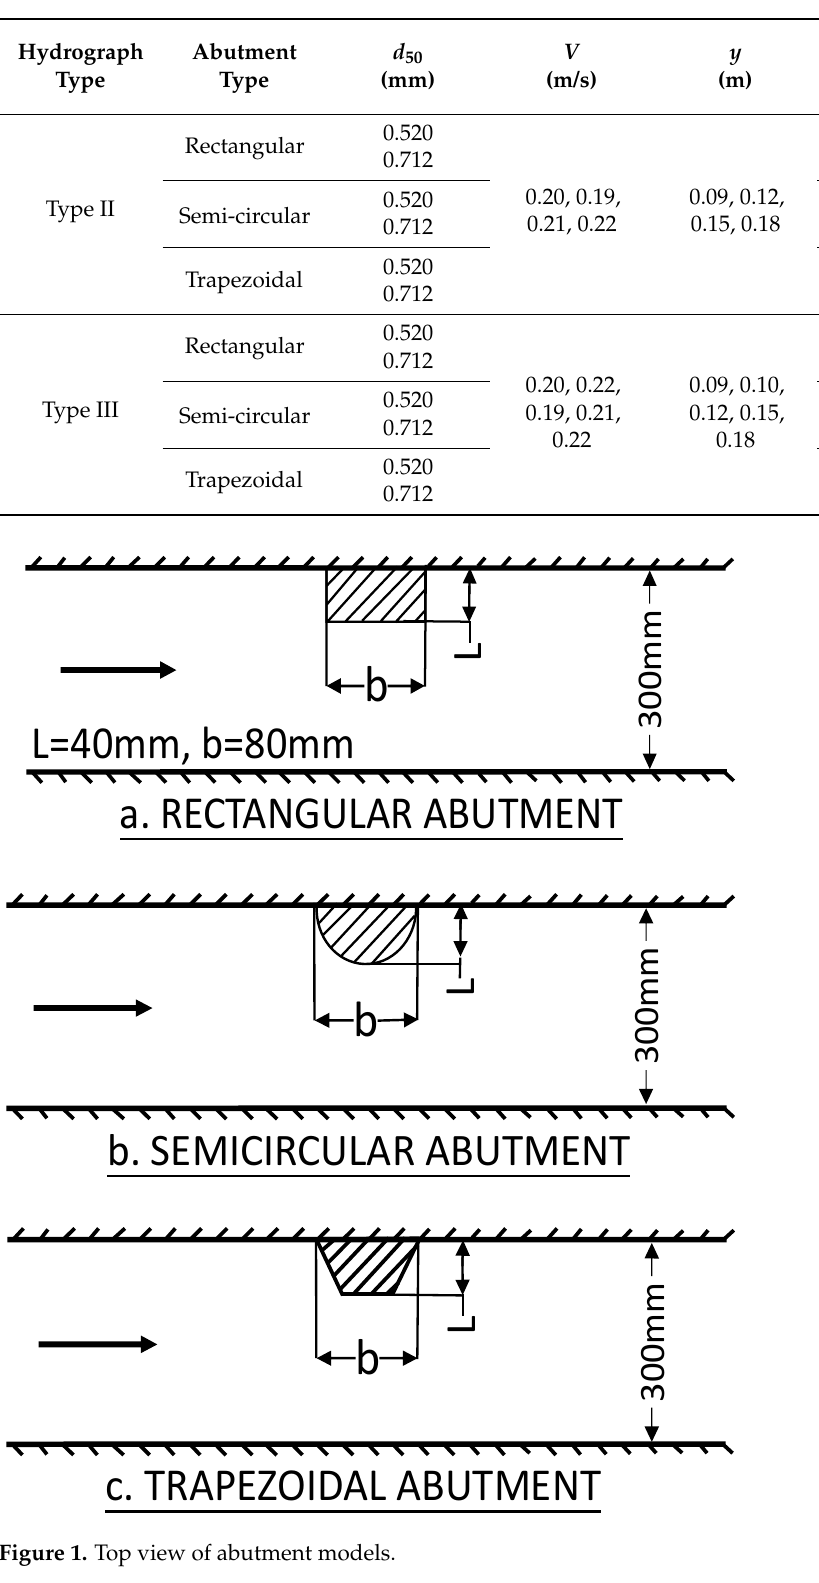
Figure 2. Three types of hydrographs used in this study.